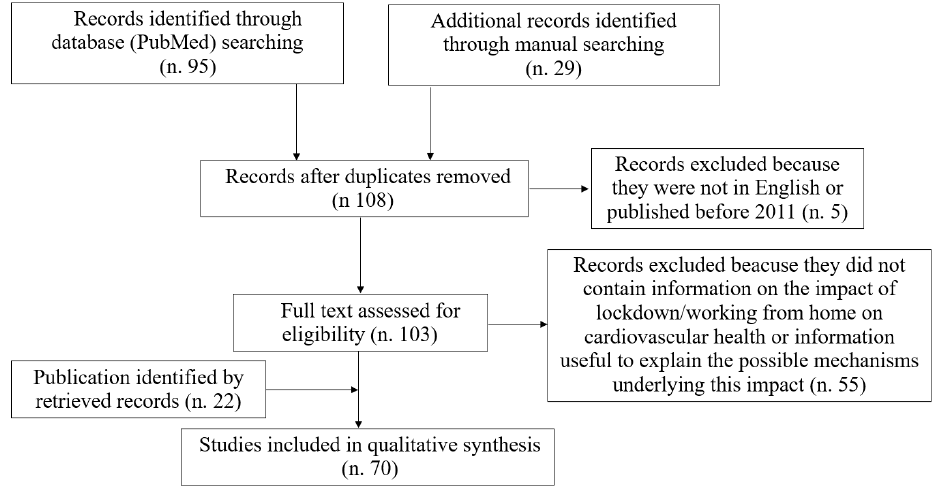
Figure 1. Literature search flowchart.